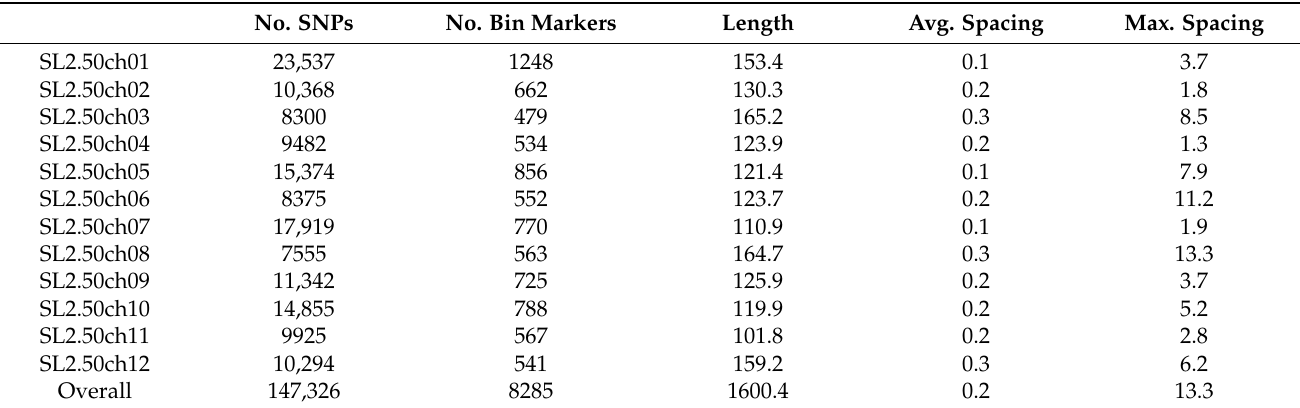
Table 1. Summary statistics for the genetic map built using the F2 generation of the cross BGV016047 × LA2278. No.